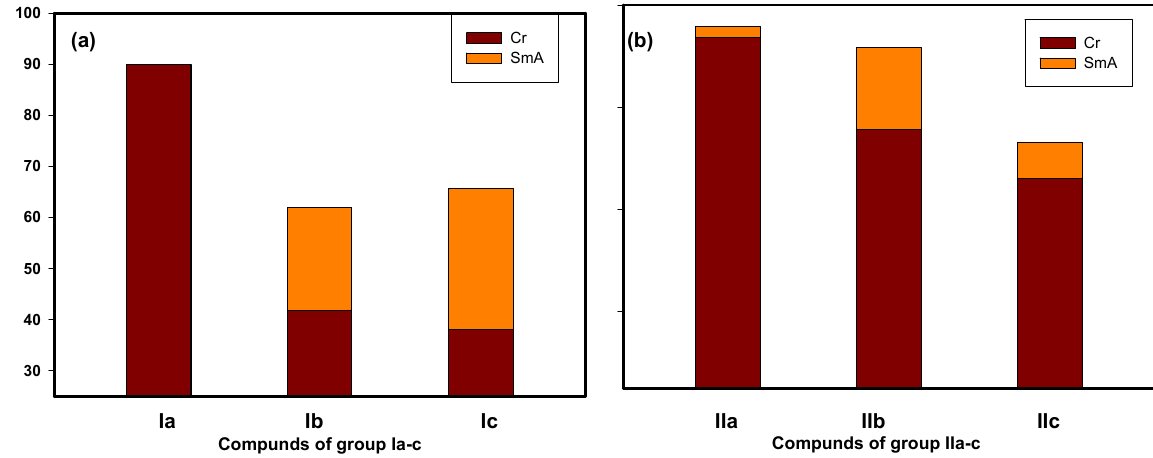
Figure 2. Transition temperature of mesophase behavior on heating of prepared derivatives for ( a ) Ia-c and ( b ) IIa-c .